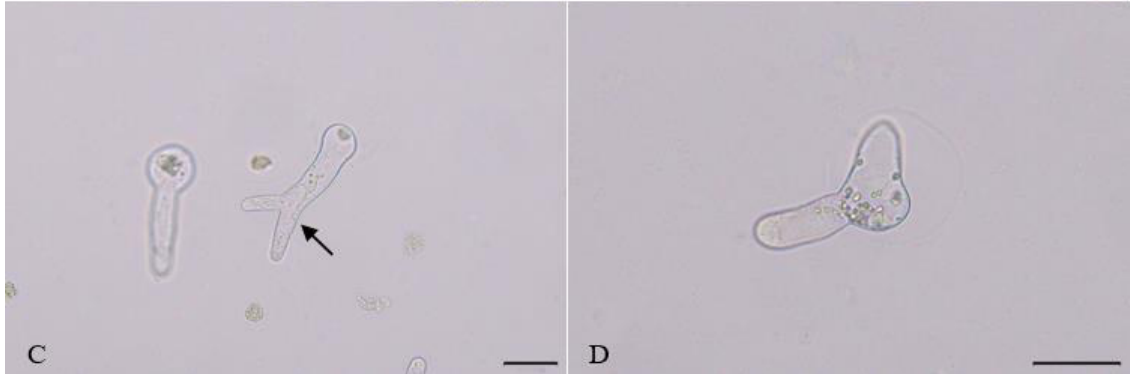
Figure 3. Pollen germination of T. distichum var. distichum in vitro. ( A ) Observation of pollen germination at 10×. ( B ) Observation of pollen germination at 20×. ( C ) Two tubes branched from the same pollen tube ( arrow ). ( D ) Two tubes generated from two parts of the pollen grain. Bars: ( A ) 100 μm. ( B – D ) 50 μm. Table 4. The effect of different mass fraction of boric acid on pollen germination of T. distichum var. distichum.